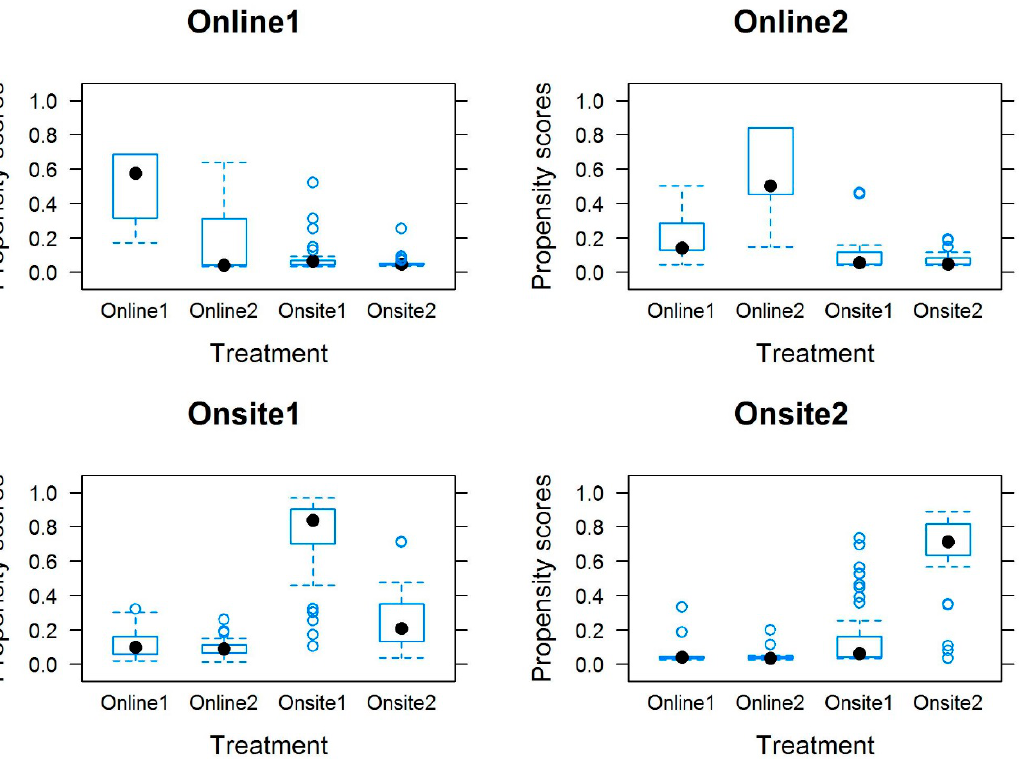
Figure 1. Propensity scores by group.